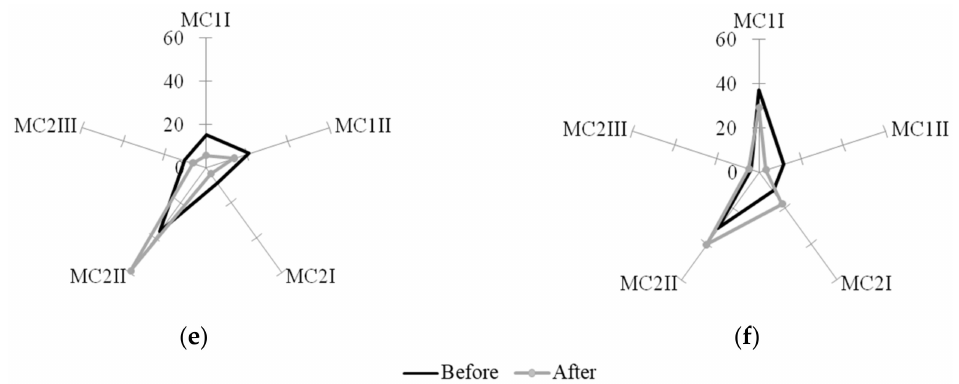
Figure 5. Quantity of cell in both morphological classes, MC1 and MC2, on PHA-films films with di ff erent surface relief before (Before) and after (After) stenting. MC2I—filiform cells, MC2II—spindle-shaped cells, MC2III—rod-shaped cells, MC1I—multinuclear rounded cells, MC1II—mononuclear rounded cells. ( a ) cultural plastic, ( b – f )—PHAs-films, 1–5.